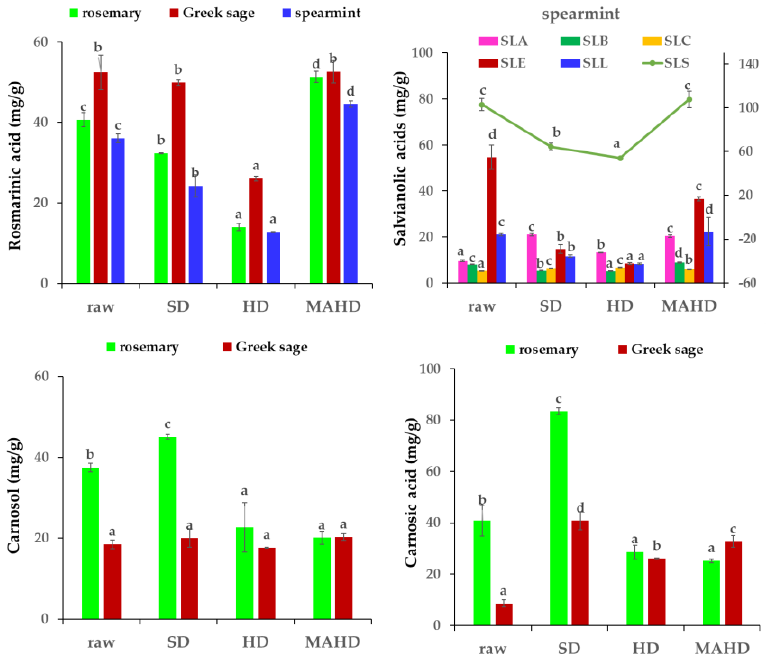
Figure 3. Major phenolic compound quantification in rosemary, Greek sage and spearmint distillation residues after the recovery of essential oils by steam-distillation (SD), hydro-distillation (HD) and microwave-assisted hydro-distillation (MAHD) by HPLC-DAD-MS. Abbreviations: SLA, salvianolic acid A; SLB, salvianolic acid B; SLC, salvianolic acid C; SLE, salvianolic acid E; SLL, salvianolic acid L; SLS, total salvianolic acids. Different letters among columns with the same color indicate statistically significant differences based on Duncan’s post -hoc test ( p ≤ 0.05).